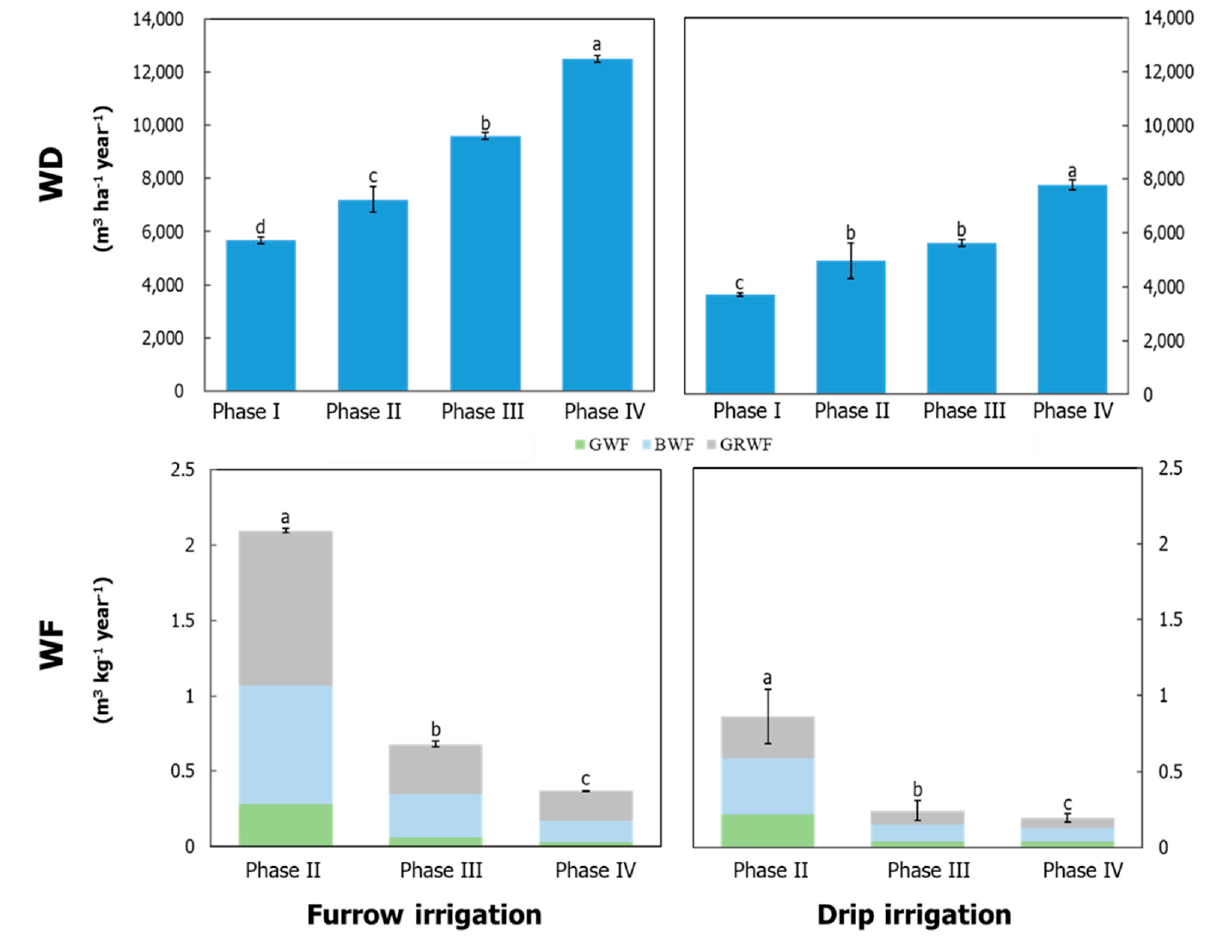
Figure 2. The water depletion (WD) and water footprint (WF) of furrow and drip irrigation pear production system in different phases. Phase I–IV represent the orchard installation phase, the primary growing phase, the low production phase, and the full production phase, respectively. The WD of the furrow system was 45.0–70.5% higher than that of the drip system, and the WFs were 2.3, 3.5, and 2 times that of the drip system. GWF was the major drive for the furrow system, while BWF played a dominant role in the drip system. Different letters represent significant differences ( p < 0.05) among the phases (a, b, c, and d).